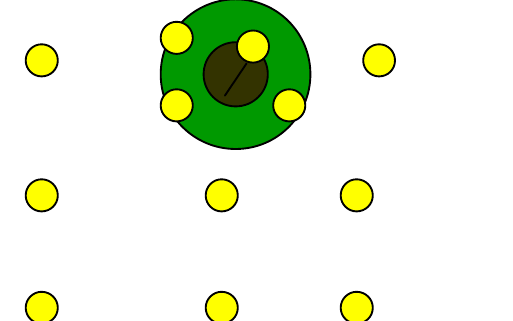
Figure 7 – Correct use of prodders during ground inspection